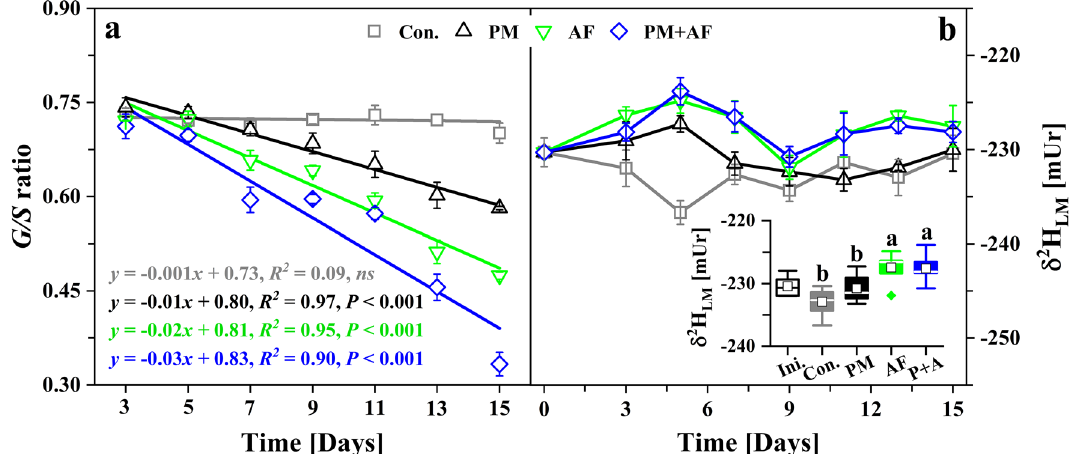
Figure 5. Temporal variations in ( a ) the lignin monomers ratio (G-lignin/S-lignin, G/S ) and ( b ) the stable hydrogen isotope values (δ 2 H LM ) of lignin methoxy groups in the degradation residues. The equations and lines represent the linear fit of the G/S ratio over the 15-day experiments. In the boxplots, white squares represent mean values, the horizontal lines represent median values, the boxes represent the 25th to the 75th percentiles, whiskers represent the 95% confidence interval, and the green diamond represents outliers. Bars labelled with different letters differ significantly ( P < 0.05). Ini., initial δ 2 H LM value of the bulk material; Con., uninoculated control; PM, Pseudomonas mandelii ; AF, Aspergillus fumigatus ; PM + AF (P + A), co-culture of the two